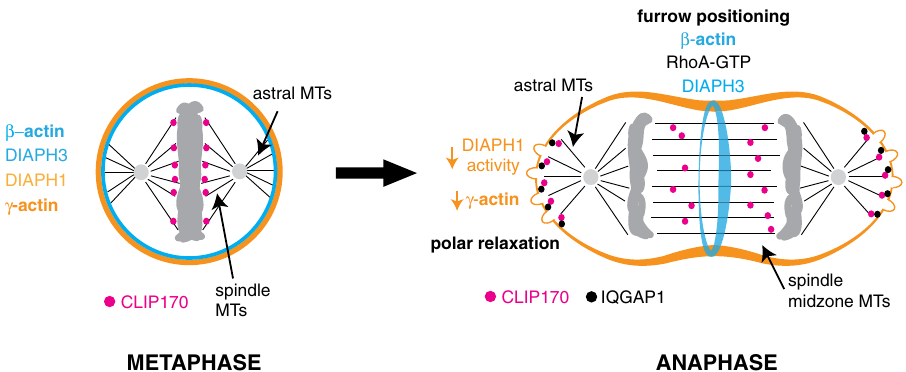
Fig. 8 Schematic outlining of how the redistribution of different actin-isoform networks and their upstream regulators could be in fl uenced by different anaphase microtubule structures in order to drive successful cytokinesis. In metaphase different actin-isoform networks and their upstream regulators are equally distributed around the cortex. However, these networks are differentially redistributed around the cortex upon entry into anaphase. Spindle midzone microtubules (MTs) establish the spatial cues for active β -actin assembly and furrow ingression at the equator, while astral microtubules deactivate DIAPH1 at the cell pole, depleting the polar γ -actin network that relaxes the poles, allowing blebbing and the equalization of internal hydrostatic pressure. MTs